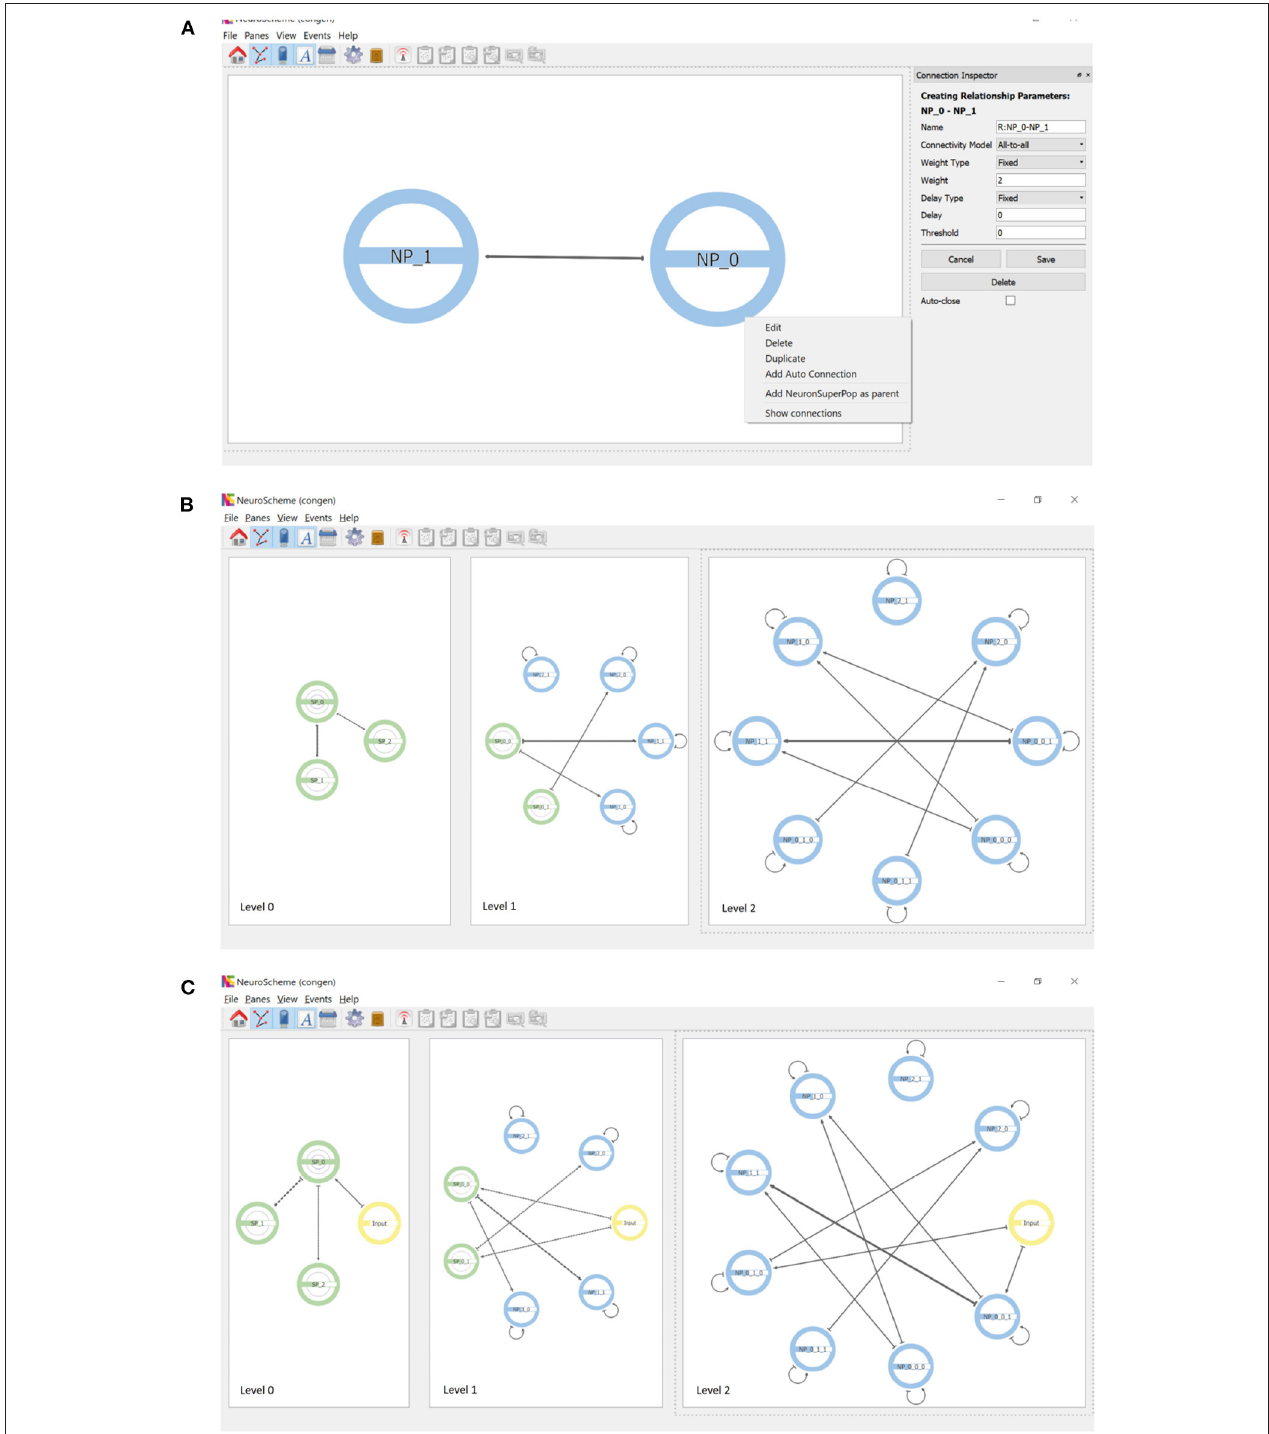
FIGURE 4 | Connections and inputs. (A) Connections are created by dragging with the mouse from the source to the target population. The panel on the right shows the parameterizable features. Auto-connections can be created through the context menu that appears when right-clicking on a population. (B) Connectivity simultaneously displayed at three levels of abstraction. Note the connections of superpopulations represent the aggregation of the connections of their descendant populations. (C) Inputs can be created as entities that are external to the hierarchy. Note that inputs appear at every level of abstraction.